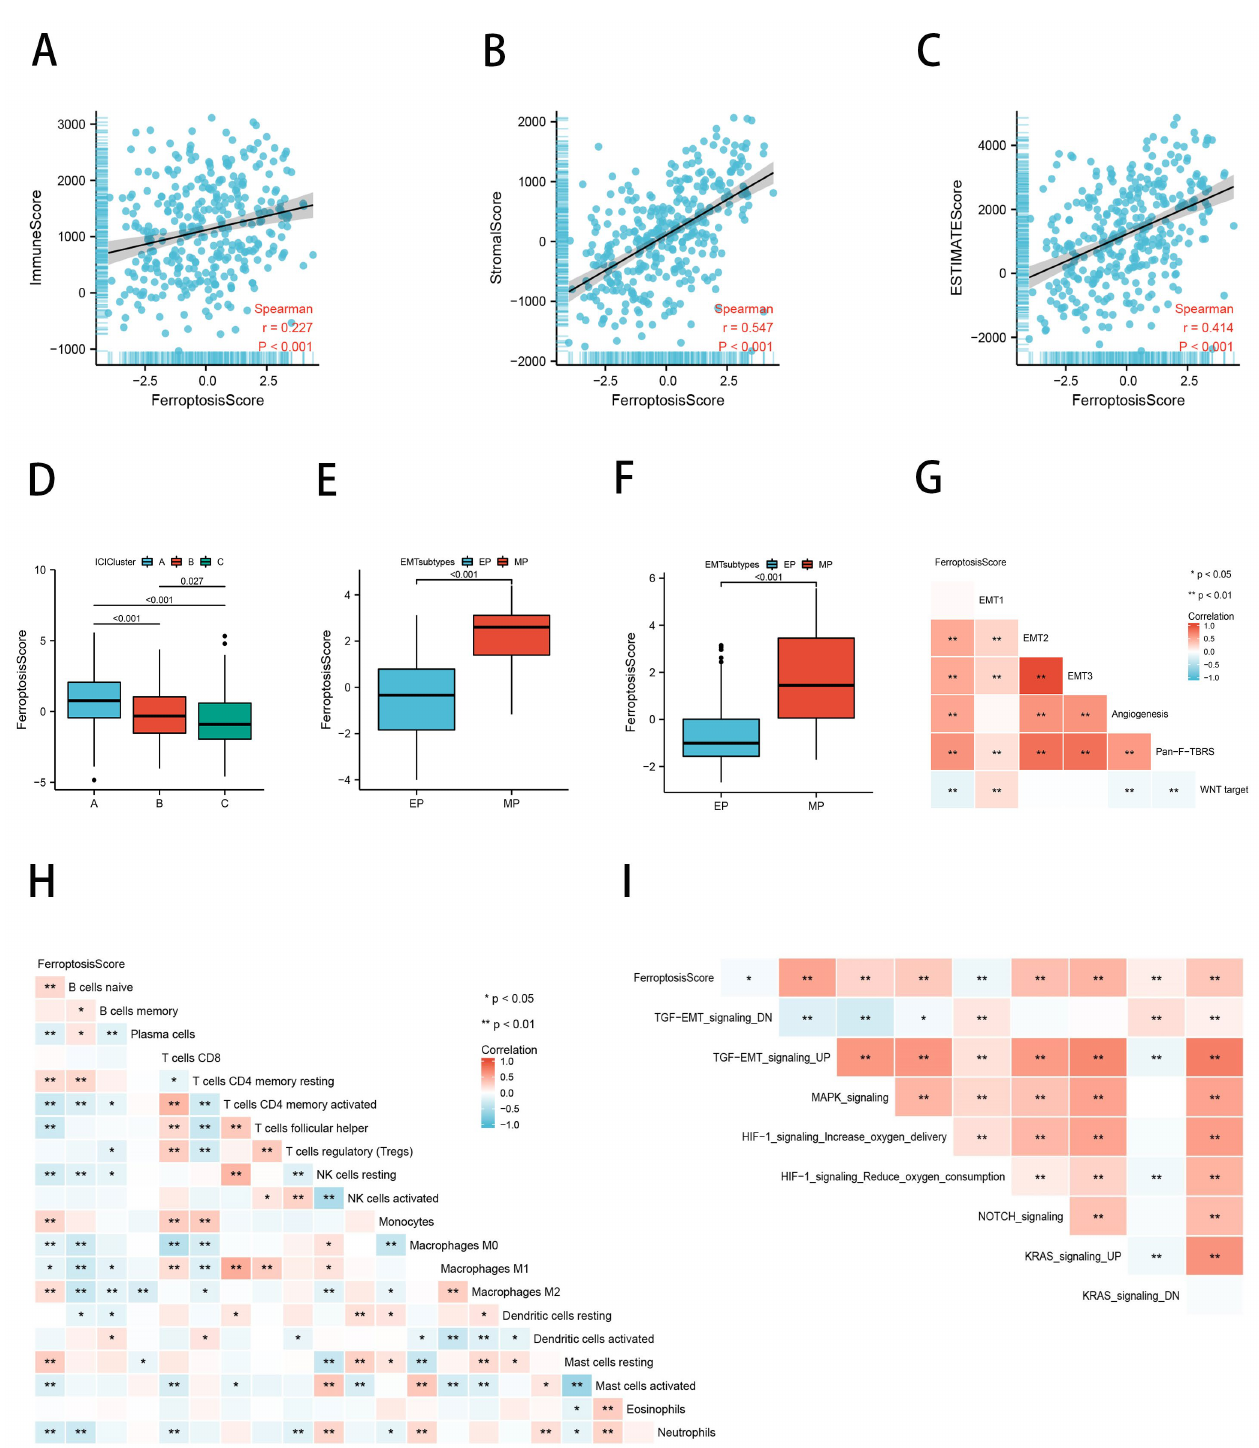
Figure 7. Ferroptosis scores correlate with TME characteristics. ( A – C ) Spearman’s Rank Correlation analysis between ferroptosis score and immune score ( A ), stromal score ( B ) and ESTIMATE score ( C ). ( D ) Ferroptosis scores differ between ICI subtypes. ( E , F ) Differences in ferroptosis scores for EMT typing in the TCGA cohort ( E ) and the ACRG cohort ( F ). ( G – I ) Heat map of the correlation between ferroptosis score and stromal activity ( G ), immune cell infiltration ( H ), and EMT-related signaling pathways ( I ).